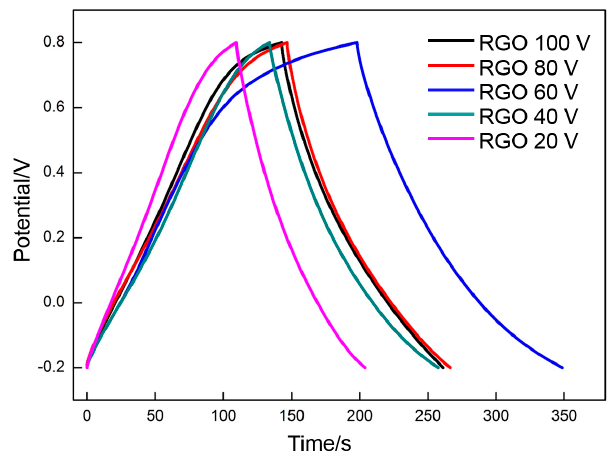
Figure 10. Galvanostatic charge/discharge curves of RGO reduced at different